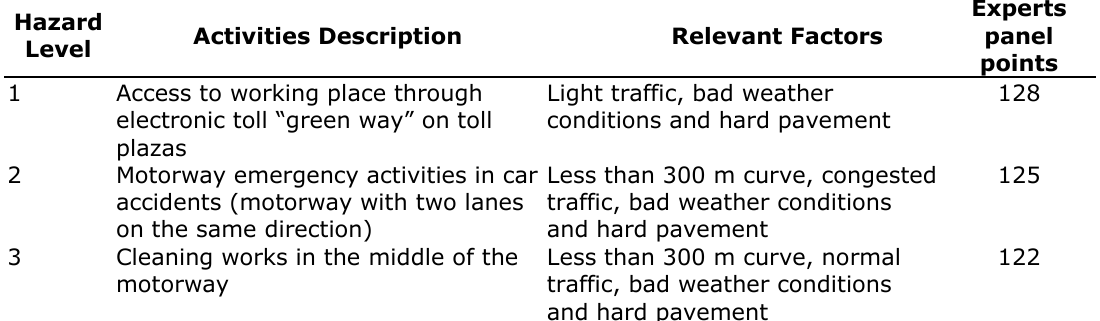
Table 1 – Relevant Activities and